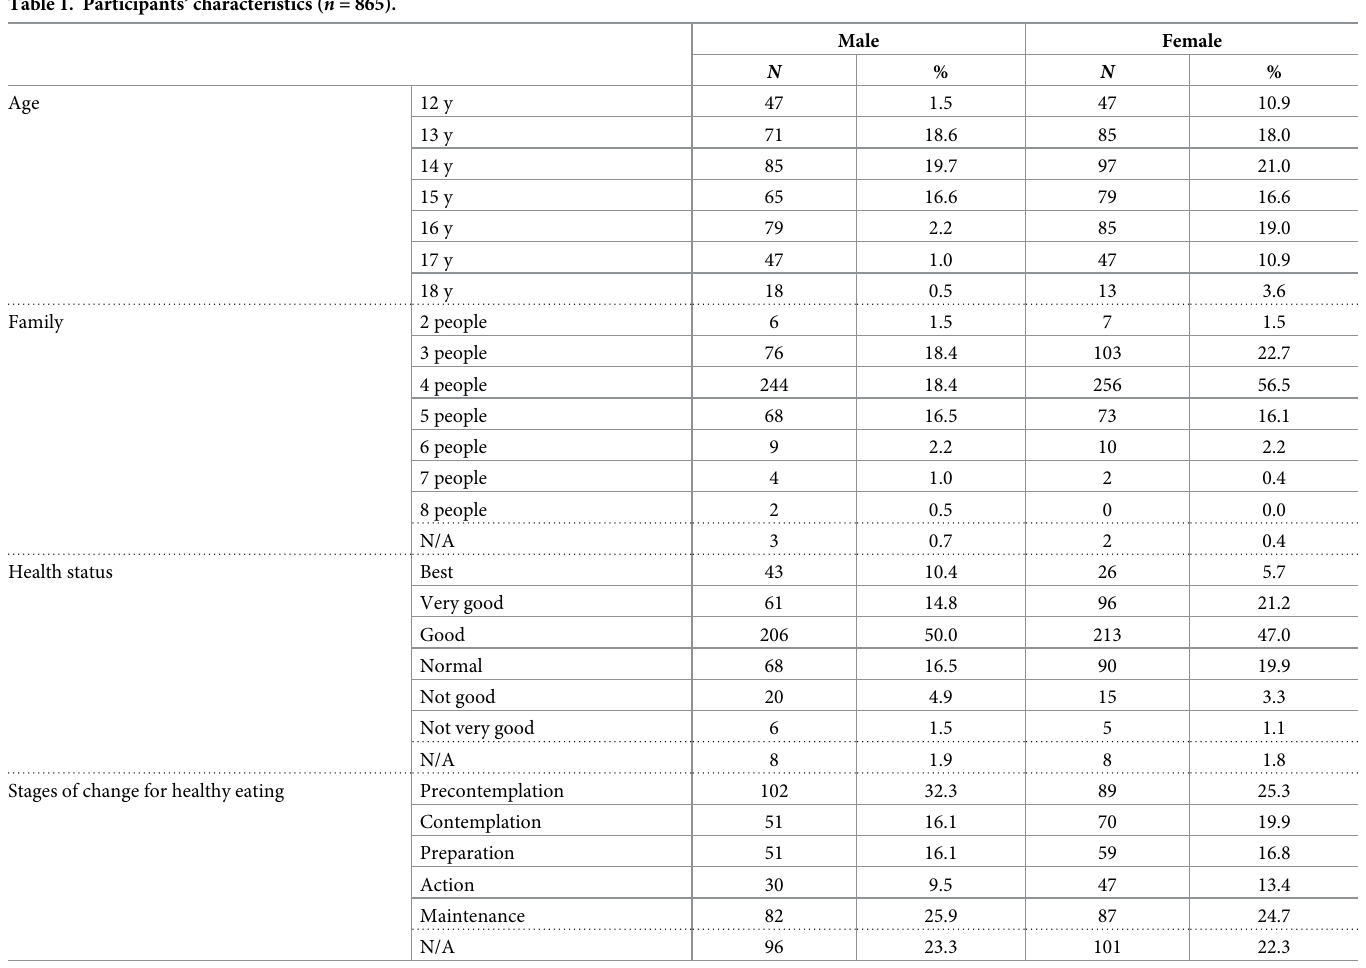
Table 1. Participants’ characteristics ( n = 865).